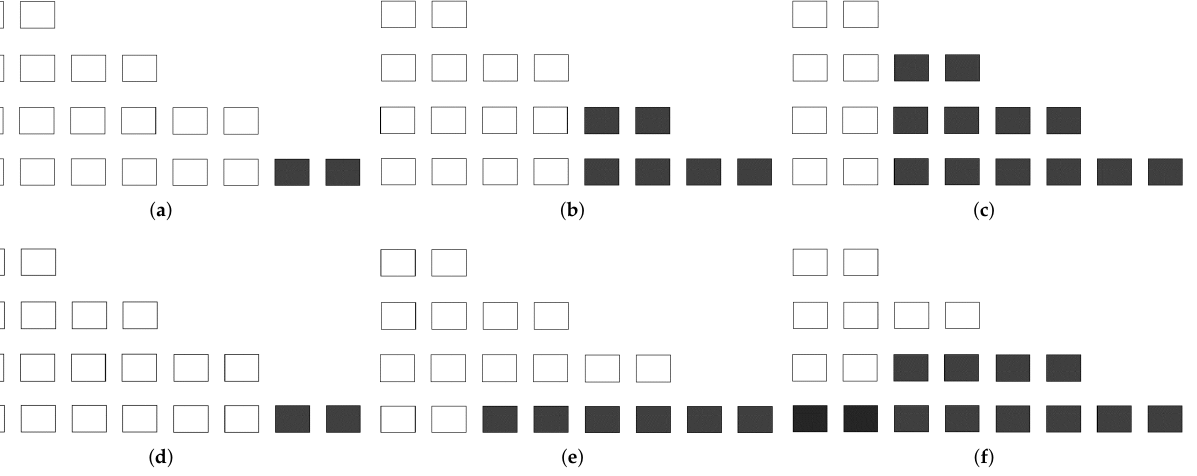
Figure 4. Proposed CAS cell replacement methods for an 8-bit square root circuit: ( a ) SR with p = 2, ( b ) SR with p = 4, ( c ) SR with p = 6, ( d ) HR with p = 2, ( e ) HR with p = 4, and ( f ) HR with p =